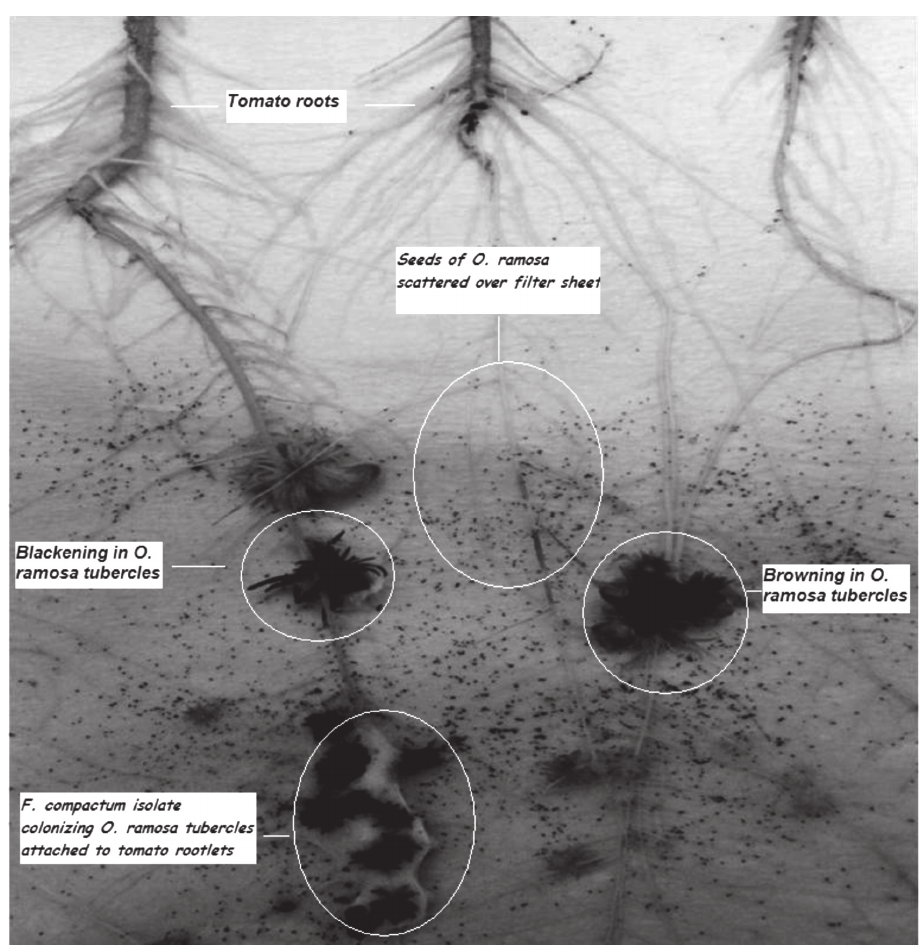
Figure 3. Pathogenicity of Fusarium compactum ( Fusarium isolate 29) on the seeds and tubercles of Orobanche ramosa formed on tomato roots grown in plastic